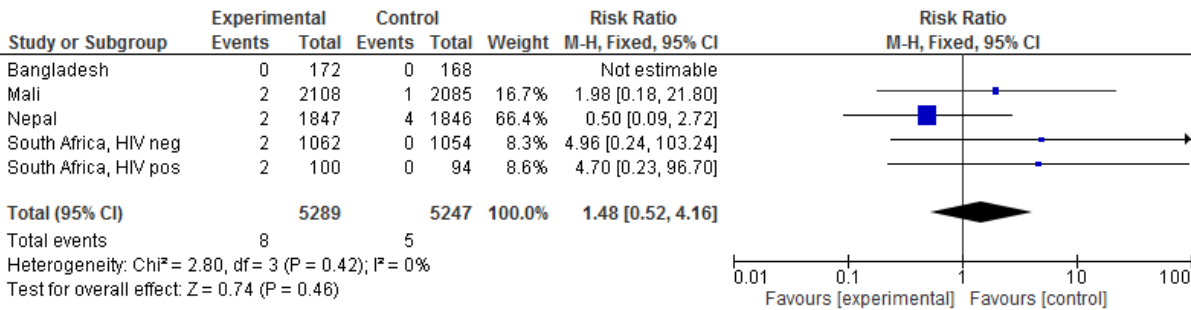
Figure 1. The effect of influenza vaccination in pregnancy on maternal mortality overall (excluding accidents/suicide). In the Bangladesh trial, a maternal death due to anaesthesia complications in the control group was judged an accident. In the Mali trial, Figure 1 presents 4 vs. 2 deaths, but the text and the appendix state 2 vs. 3 deaths. Two deaths due to electrocution, and ‘cervical fracture, post-trauma’ in the control group were excluded. In the Nepal trial, the abstract indicates that 5 vs. 3 women died in the control and intervention groups, respectively. The text and the supplementary table indicate 5 vs. 2, and these numbers were used for this study. Maternal death due to suicide in the control group in the Nepal trial was excluded.